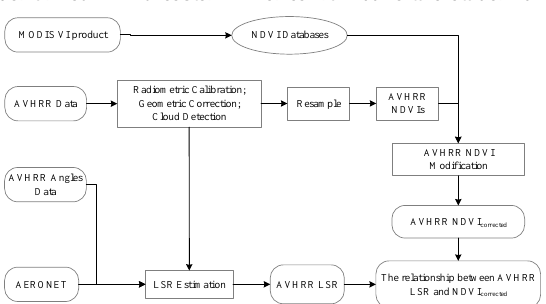
Figure 1. Flow chart of the AVHRR LSR determination